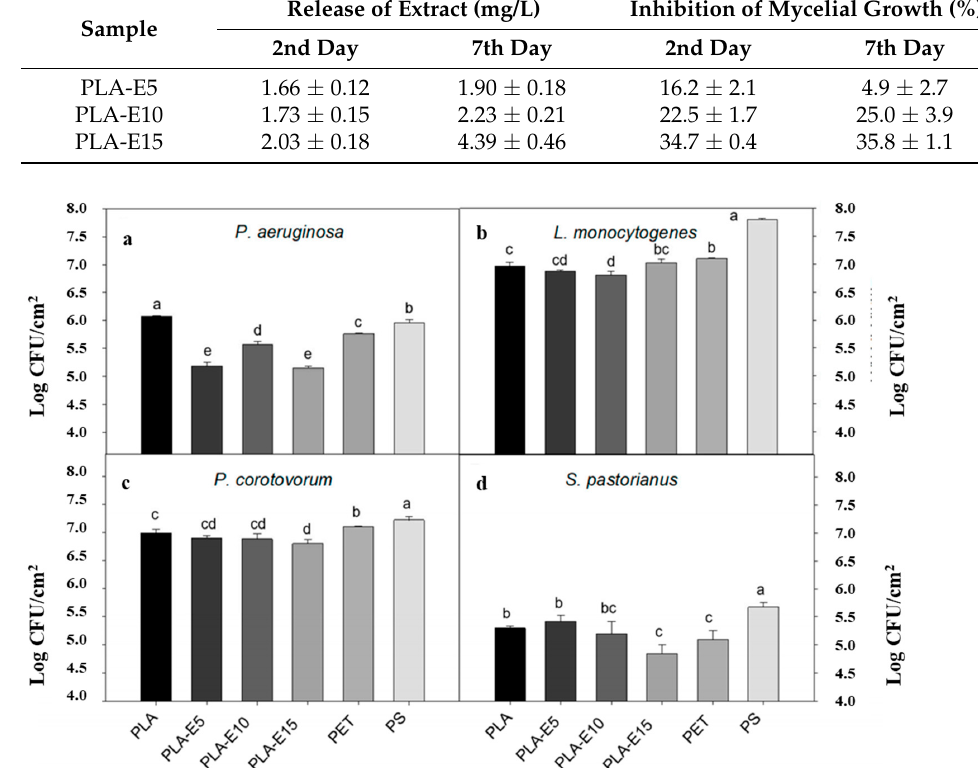
Table 11. Release of extract and inhibition of mycelial growth of B. cinerea onto PLA-E samples [99]. Sample